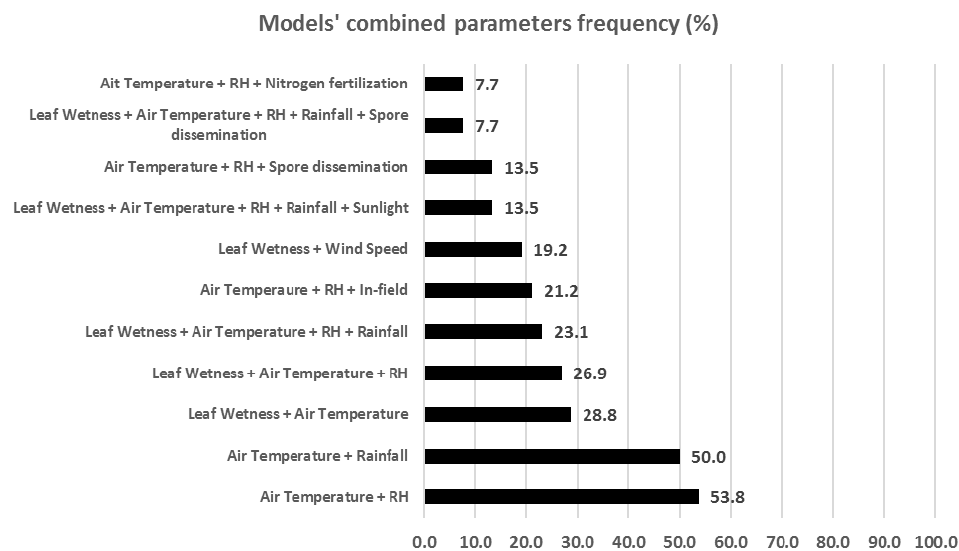
Figure 2. Frequency of combinations of meteorological variables used in 52 rice blast forecasting models (RH = Relative